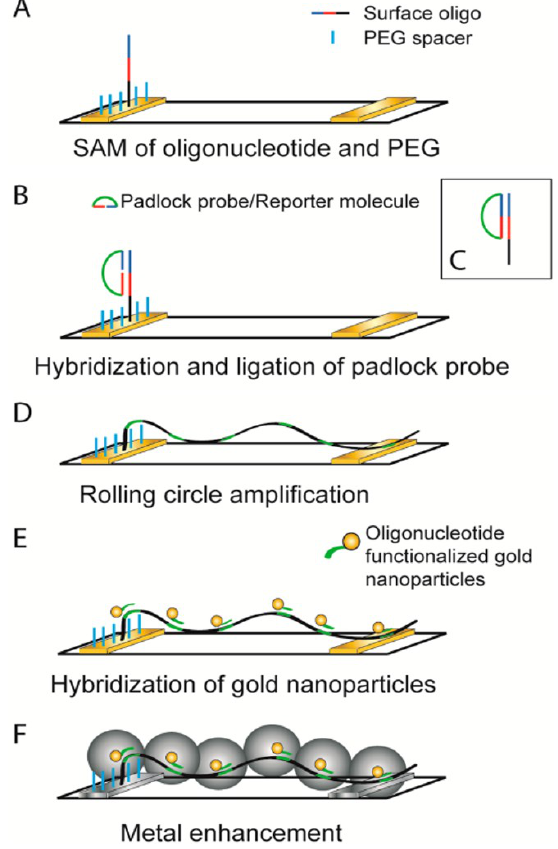
Figure 7. Schematic illustration of formation of metalized wires from stretched rolling circle amplification products to generate an electrical signal. A padlock probe, whose ends have been designed to hybridize head-to-tail on a target sequence, is hybridized and ligated to a self-assembled monolayer (SAM) of oligonucleotides containing the target sequence and poly(ethylene glycol) (PEG) alkane backfiller on a gold electrode ( A – C ); ( D ) This circle is then used for RCA, creating a long single-stranded product on the electrode; ( E ) Oligonucleotide-functionalized gold nanoparticles are then hybridized to the product; ( F ) With the aid of these particles, the single-stranded DNA threads are metalized using either a silver or gold salt solution to form metal wires. Reprinted with permission from [104]. Copyright 2014, American Chemical Society.